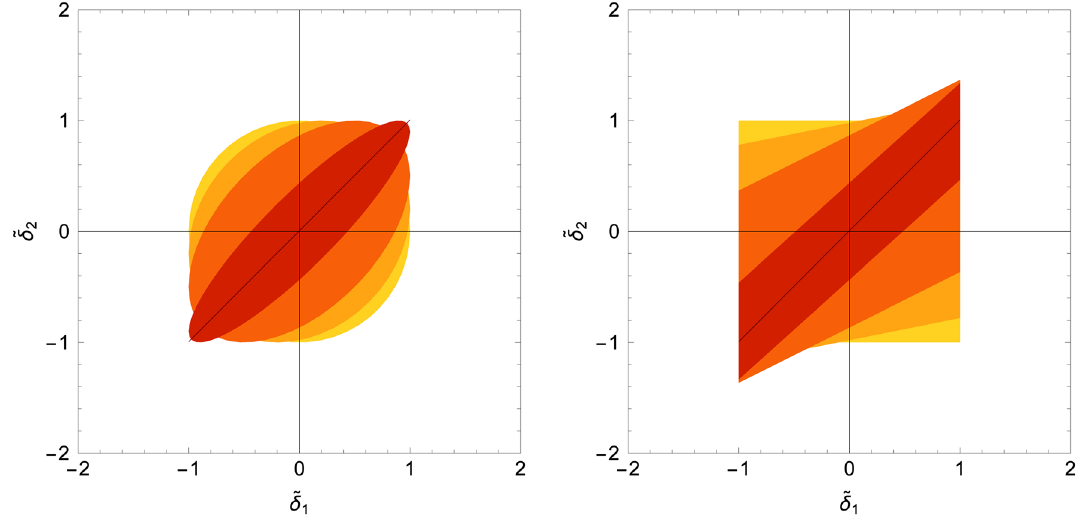
Fig. 10 Ranges of variation for ˜ δ 1 and ˜ δ 2 for ρ = 0 , 0 . 2 , 0 . 5 , 0 . 9 , 1, going from light ( yellow ) to dark ( red ). The variation over a hyperball ( left ) or a hypercube ( right ) is considered